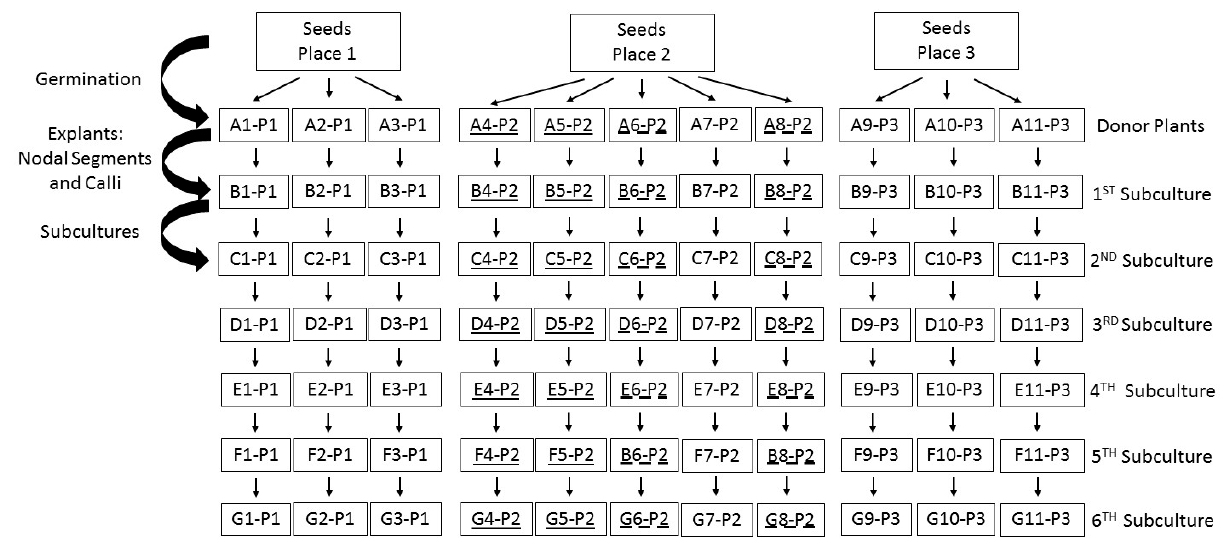
Figure 1. Schematic illustration of the plant individuals analyzed in this study. The first generation of plants (Group A) was obtained from in vitro germination of seeds of donor plants from Montes Claros, GO (Site 1); Caçu, GO (Site 2); and Ouroana, GO (Site 3). These plants provided donate nodal segments explants and calluses (Group B, donor plants). The first, second, third, fourth, fifth, and sixth subcultures (Groups C–G) were produced from explants donated by plants of group B. Plants used only as callus donor explants are shown underlined, and donors used as nodal segment explants are shown with a dash line. Plants with no underlining were used as donors for explants for both experiments (from [35] with adaptation).